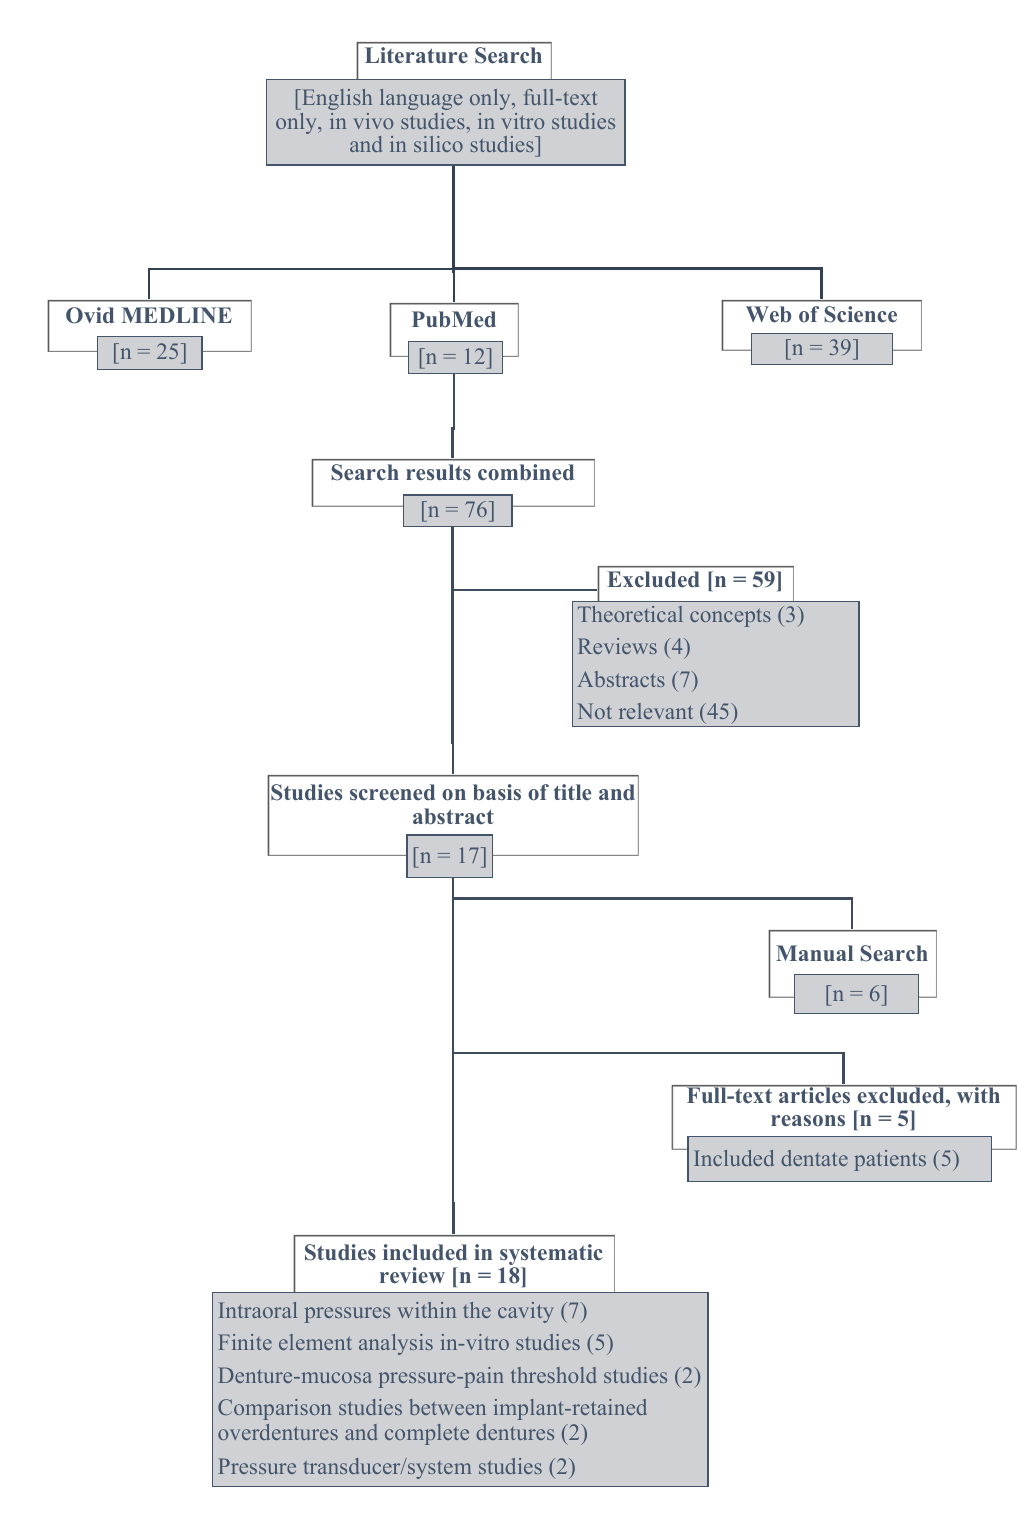
Figure 1. Flowchart of the systematic literature